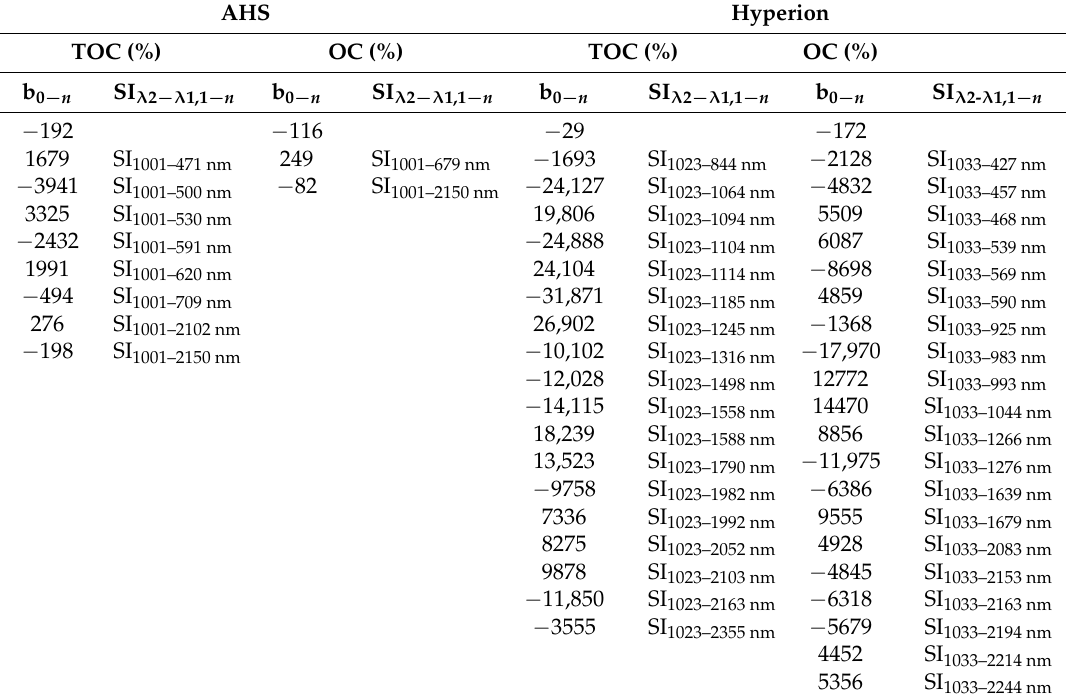
Table 3. Expressions of the best SMLR models for soil organic C estimation using AHS and